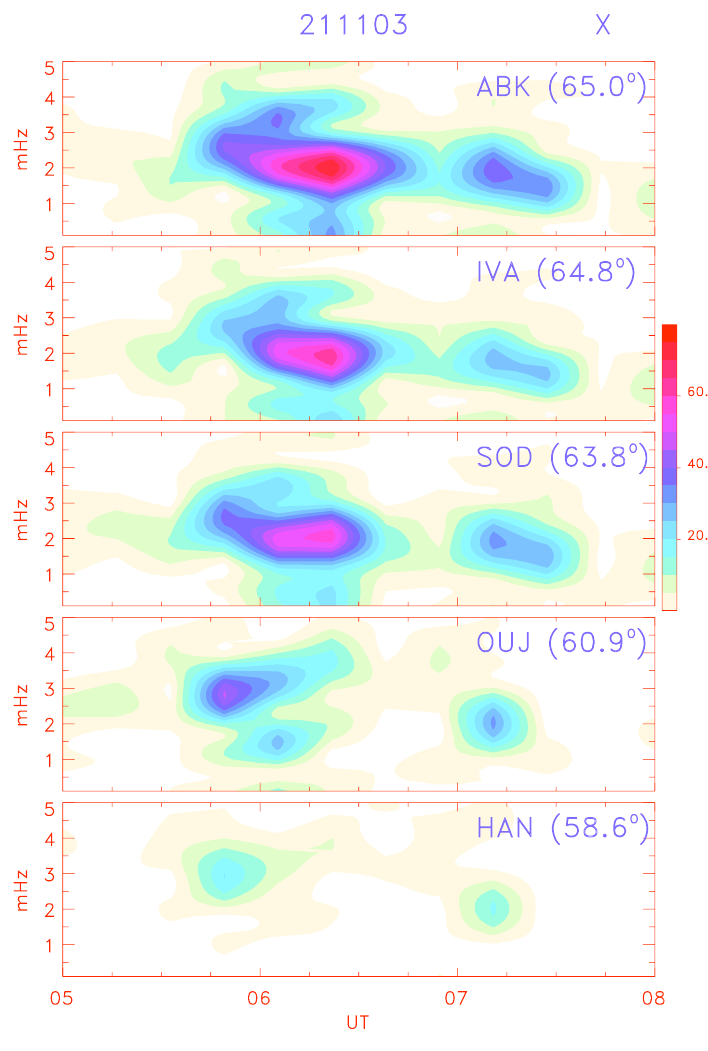
Fig. 5. Dynamic amplitude spectra of Pc5 pulsations (nT/mHz 0 . 5 ) observed at selected IMAGE